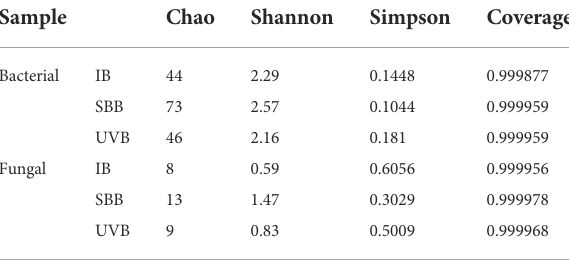
TABLE 2 Diversity Index Analysis of bioaerosols of the single BTF and UV-BTF at the genus levels. Sample